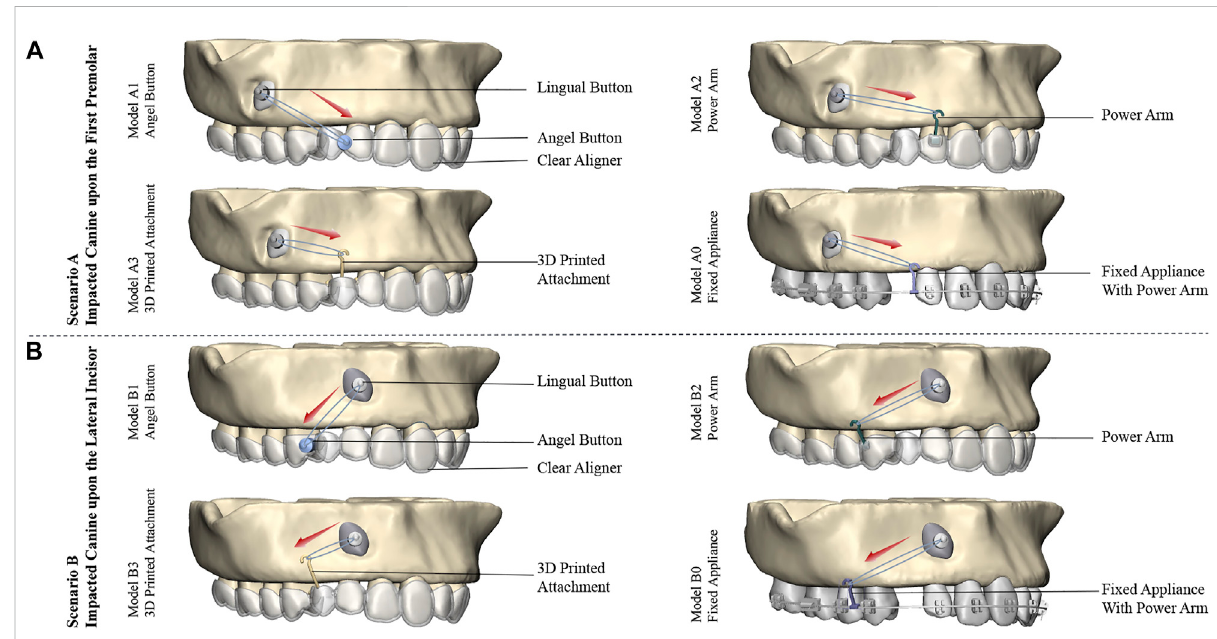
FIGURE 2 Traction models of the right labially impacted canines with clear aligners and fi xed appliance: (A) Traction models of impacted canine in Scenario A. The clear aligner models are Model A1 (Angel Button), Model A2 (Power Arm), and Model A3 (3D Printed Attachment), and the control model is Model A0 (Fixed Appliance). (B) Traction models of impacted canine in Scenario B. The clear aligner models are Model B1 (Angel Button), Model B2 (Power Arm), and Model B3 (Printed Attachment), and the control model is Model B0 (Fixed Appliance). 8 models were designedwith the same traction force of 0.6N. Red arrows indicate the direction of the traction.